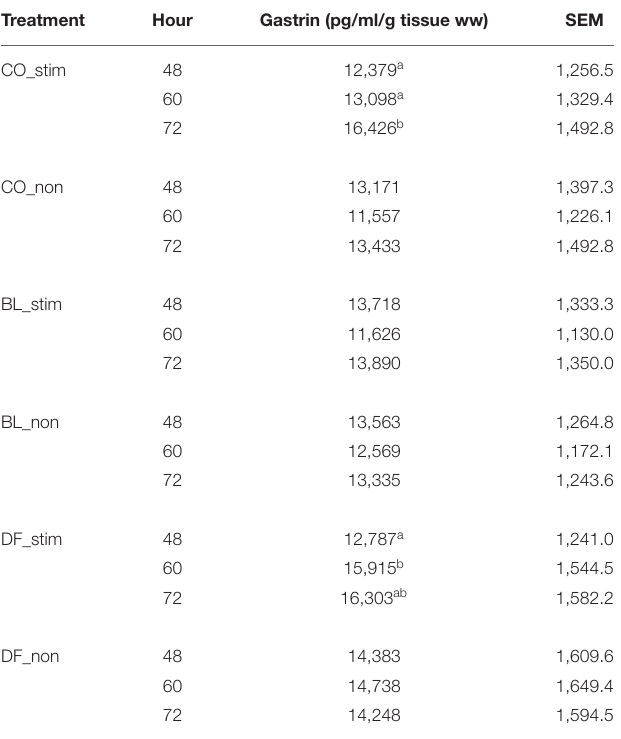
TABLE 2 | Media gastrin (pg/ml/g tissue ww) as assessed by spectrophotometric assay of a commercial ELISA for porcine gastrin over time in porcine antral explants stimulated with either 10 − 5 M carbachol (_stim) or sterile PBS (_non). Treatment